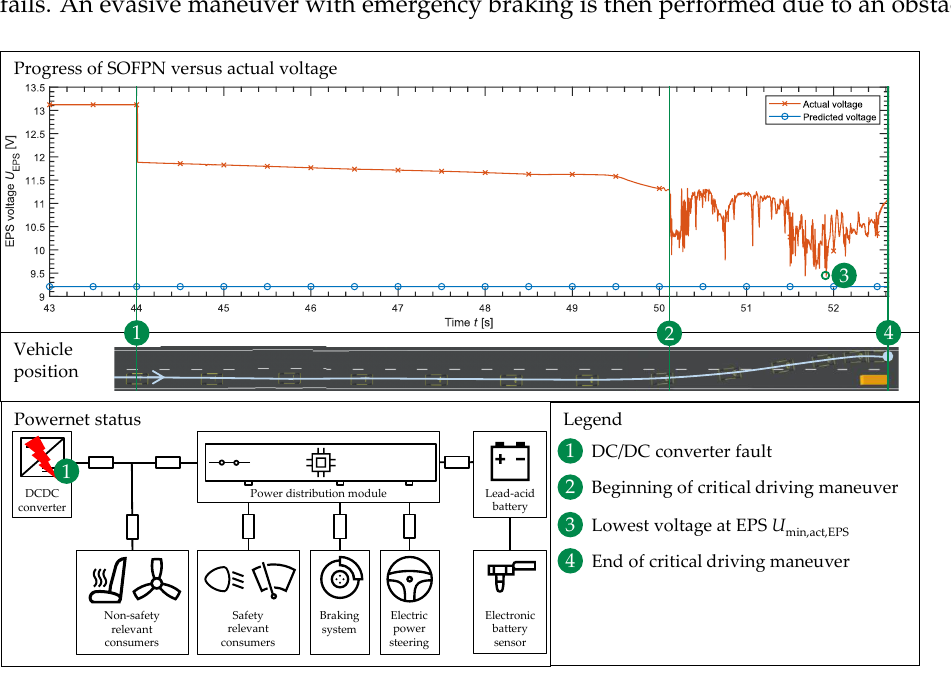
Figure 9. Comparison of the predicted voltage by the SOFPN with the actual voltage at the EPS in the event of a DCDC converter fault and subsequently evasive maneuver including emergency